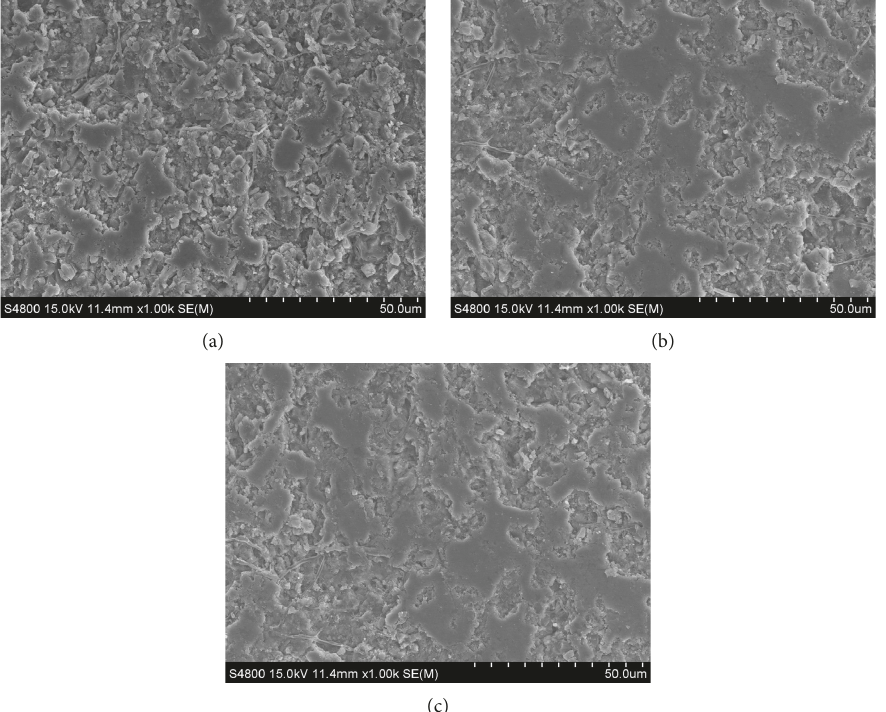
Figure 7: Micromorphology of the bauxite surface: (a) before the polishing process; (b) after 20 × 10 4 polishing cycles; (c) after 28 × 10 4 polishing cycles.